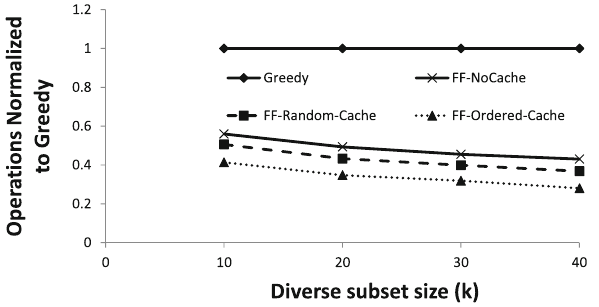
Fig. 11 Impact of cache without